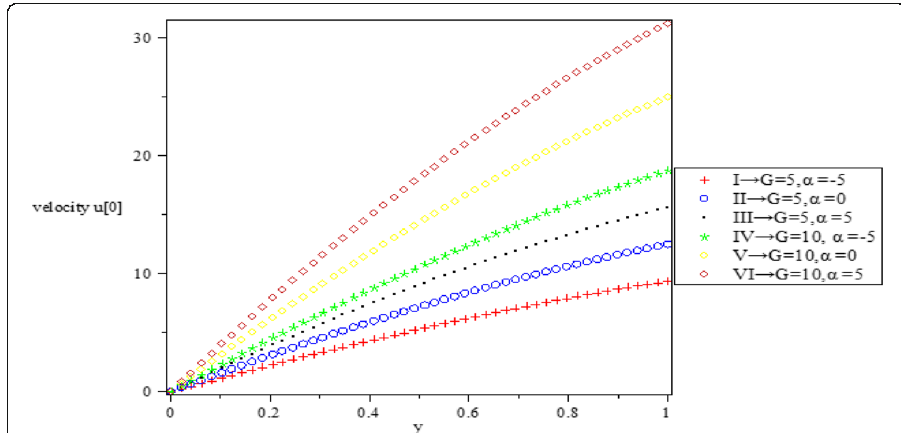
Fig. 5 Zeroth-order velocity (u[0] profile, r = 2 and β = 1.5)